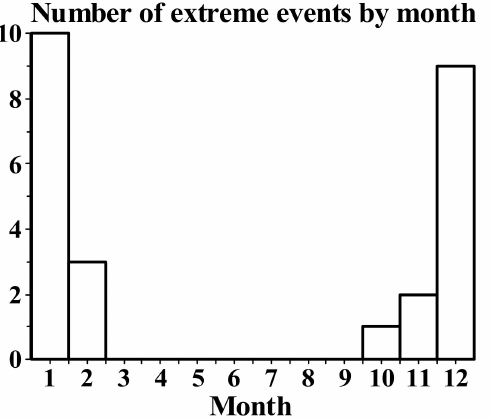
Figure 3. Seasonal distribution of extreme ionospheric events from the Irkutsk database.